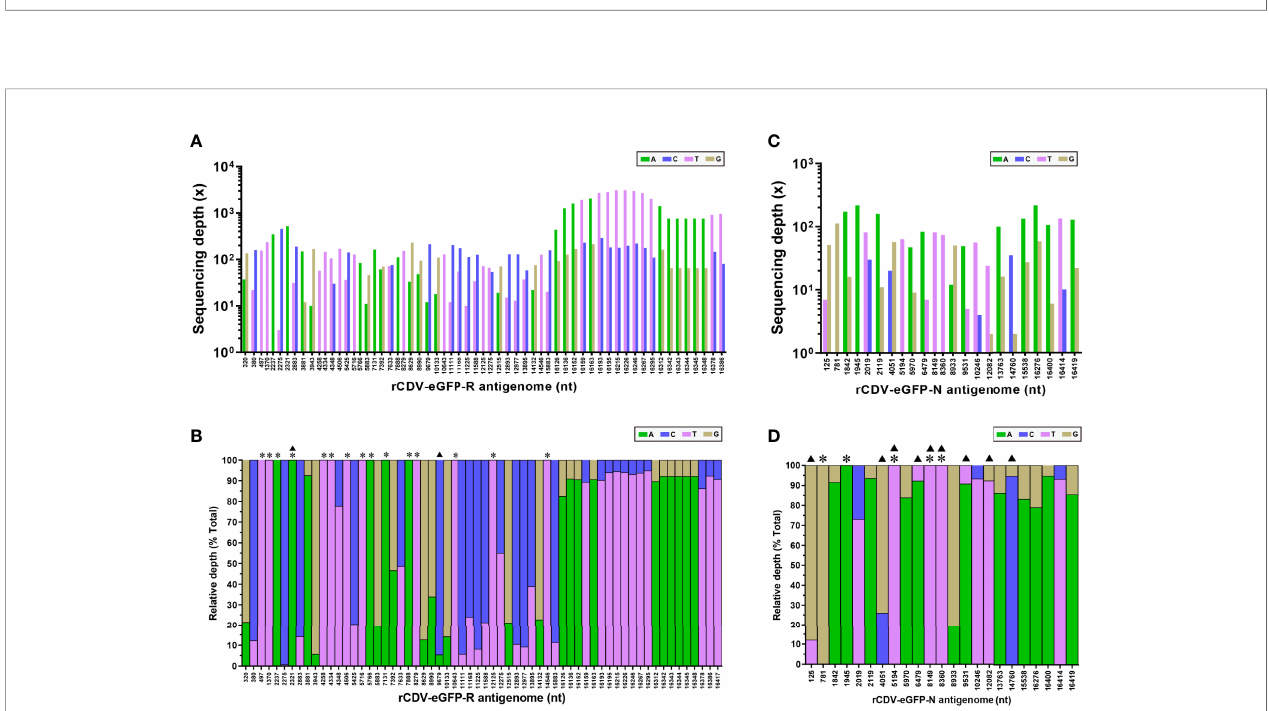
FIGURE 3 | Sequencing depths of NGS for detectable positions with SNM in rCDV-eGFP-R and -N antigenomes at P47. Absolute (A) and relative (B) sequencing depths of rCDV-eGFP-R. Absolute (C) and relative (D) sequencing depths of rCDV-eGFP-N. *Relative depth of 100% at a given site. ▲ Occurrence of transversion at a given site.